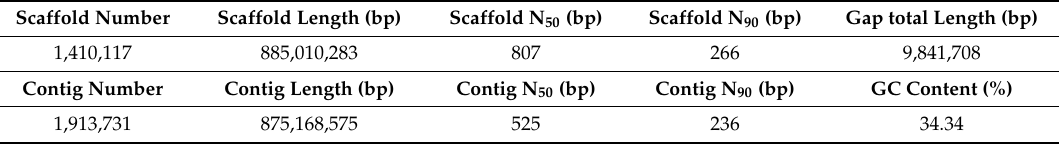
Table 2. Statistics of the Luffa cylindrica L. genome assembly.